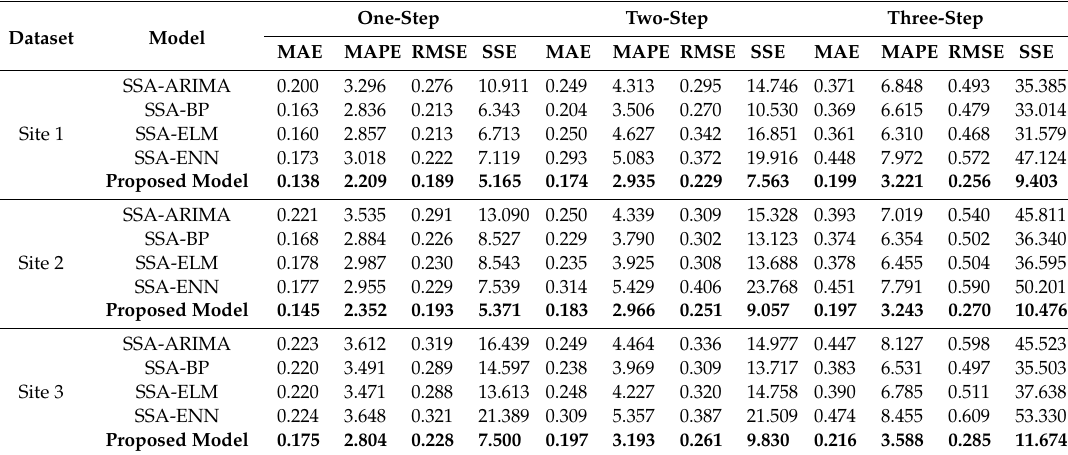
Table 3. Evaluation metrics comparison of proposed model with relative hybrid models.